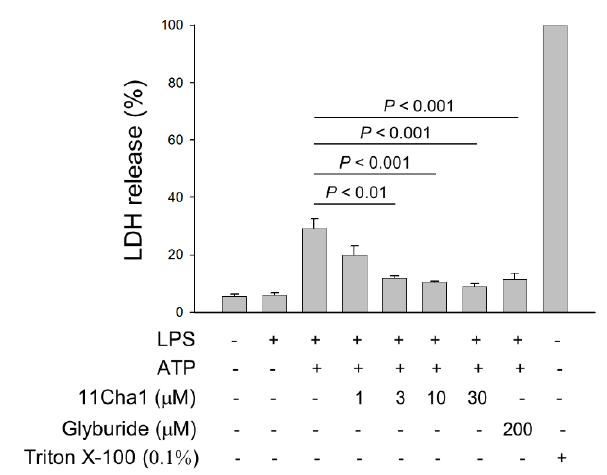
Figure 7. Effect of 11Cha1 on ATP-induced pyroptosis reaction. THP-1 cells were seeded and differentiated by 50 nM PMA for 48 h and then primed with 1 μg/mL LPS for 4 h. The cells were pre-treated with or without the indicated agent for 30 min and then treated with 5 mM ATP for another 2 h. After the treatment, the LDH levels in medium was determined using LDH assay kit. Data are expressed as mean ± SEM of five independent determinations.